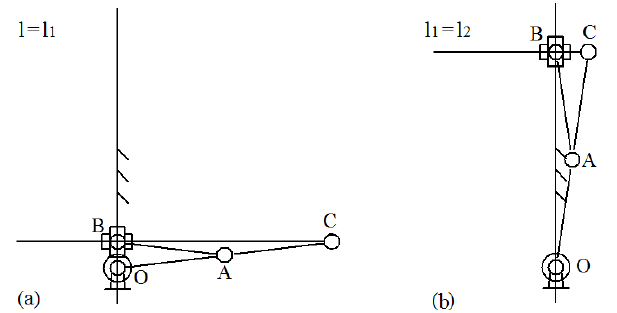
Figure 3. Special positions of orthogonal mechanism.